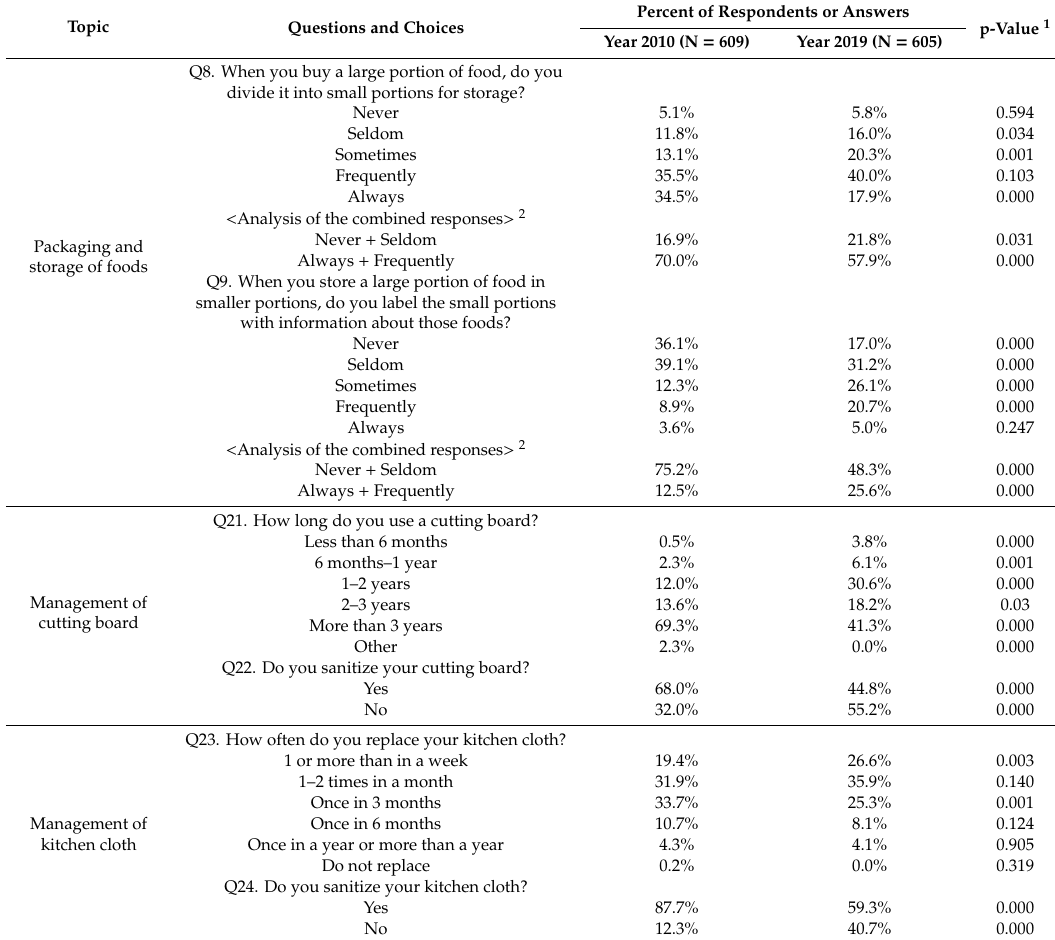
Table 3. The common high-risk behaviors of consumers were observed from surveys performed in 2010 and 2019. Questions and